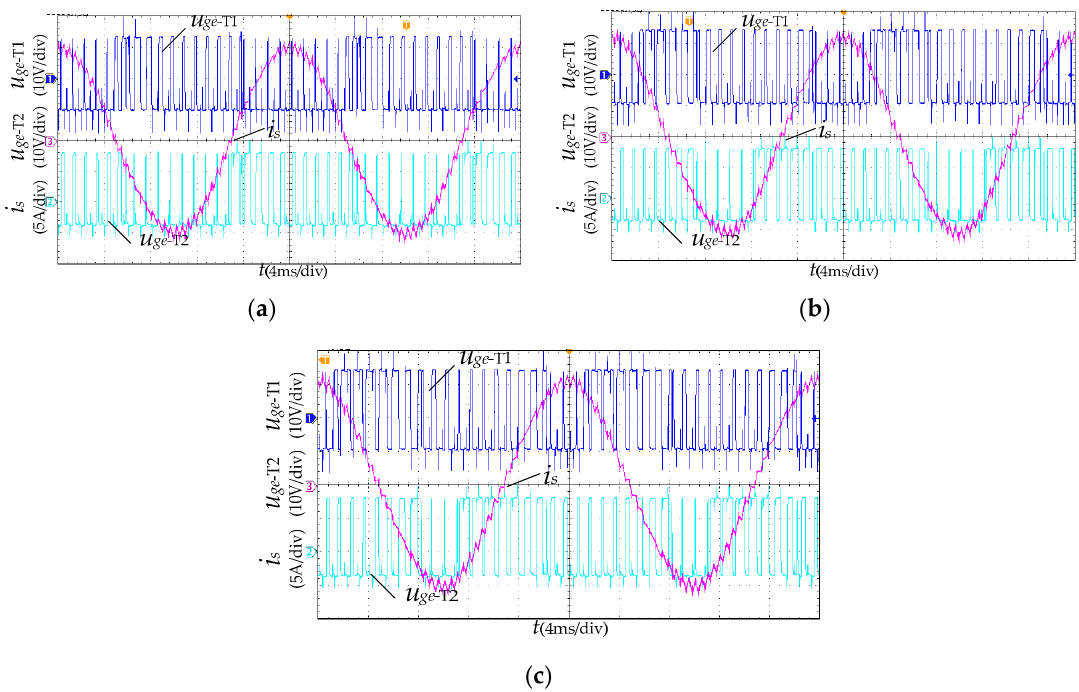
Figure 18. Steady-state experimental waveforms under different loss thresholds: ( a ) I th = 2 A, Δ E* = 0.13; ( b ) I th = 10 A, Δ E* = 0.08; ( c ) I th = 13 A, Δ E* = 0.05.